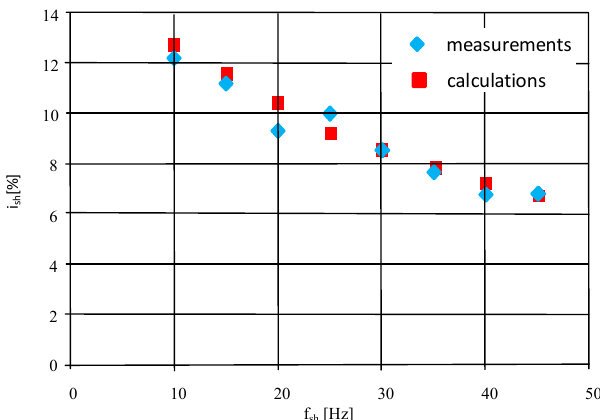
Figure 2. Measured and calculated current subharmonics (related to the rated current) vs. the fre- quency of voltage subharmonics for motor 2 and voltage containing negative sequence subharmonics of the value U sh = 1 % U 1 .